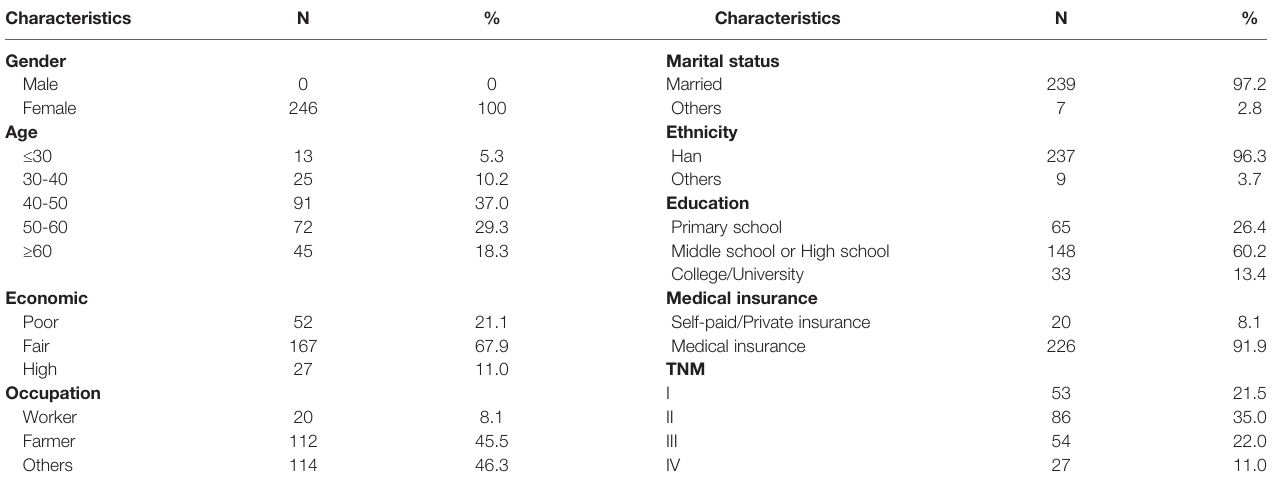
TABLE 2 | Socio-demographic and clinical characteristics of the Sample (n = 246).